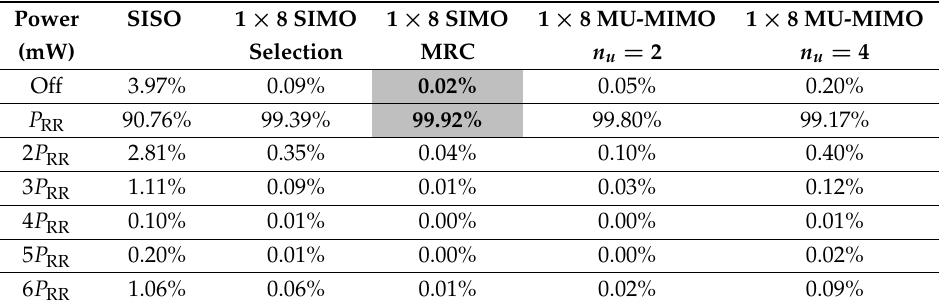
The power distribution with the different transmission modes in the typical